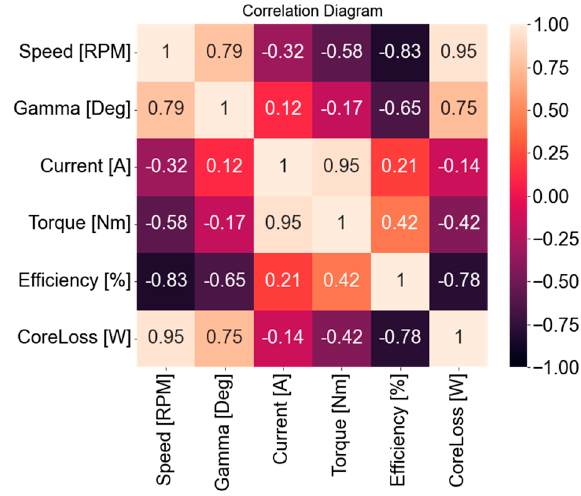
Figure 3. Correlation diagram.